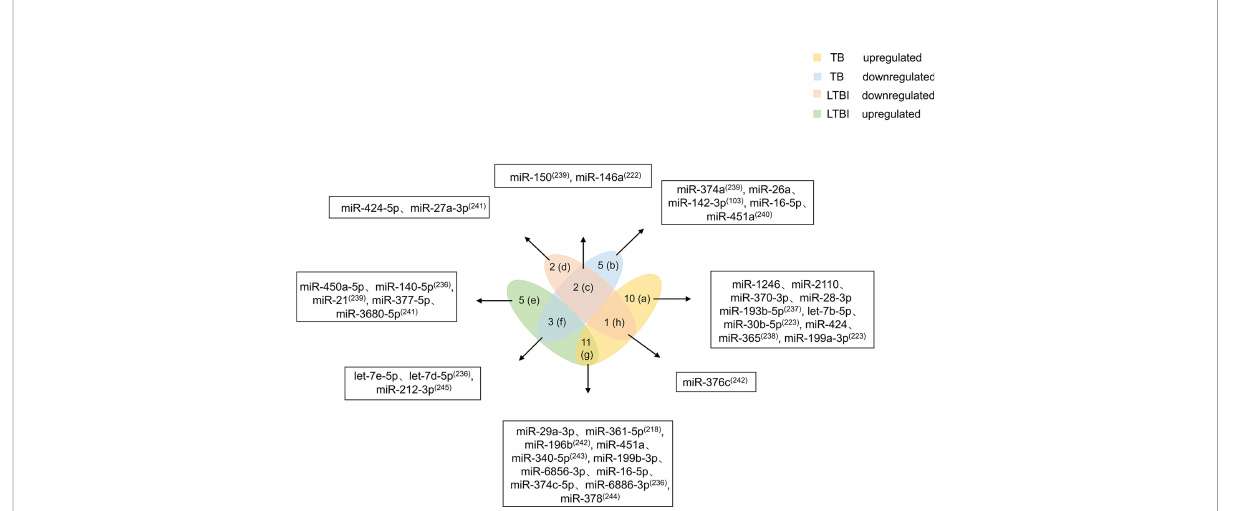
FIGURE 4 Differential expression of miRNAs in TB and LTBI. Differentially expressed miRNAs were divided into eight categories (A – H) . miRNAs in the a region are only upregulated in TB patients. miRNAs in the b region are reduced only in TB patients. miRNAs in the c region diminish in TB and LTBI. miRNAs in the d region are decreased in patients with LTBI. miRNAs in the e region are increased in patients with LTBI. miRNAs in the f region are elevated in LTBI but downregulated in TB. miRNAs in the g region are both increased. miRNA in the h region is higher in TB, but decreases in LTBI. miRNAs in the (C, F – H) regions should be focused on, and miRNAs in the f and h regions have higher potential for